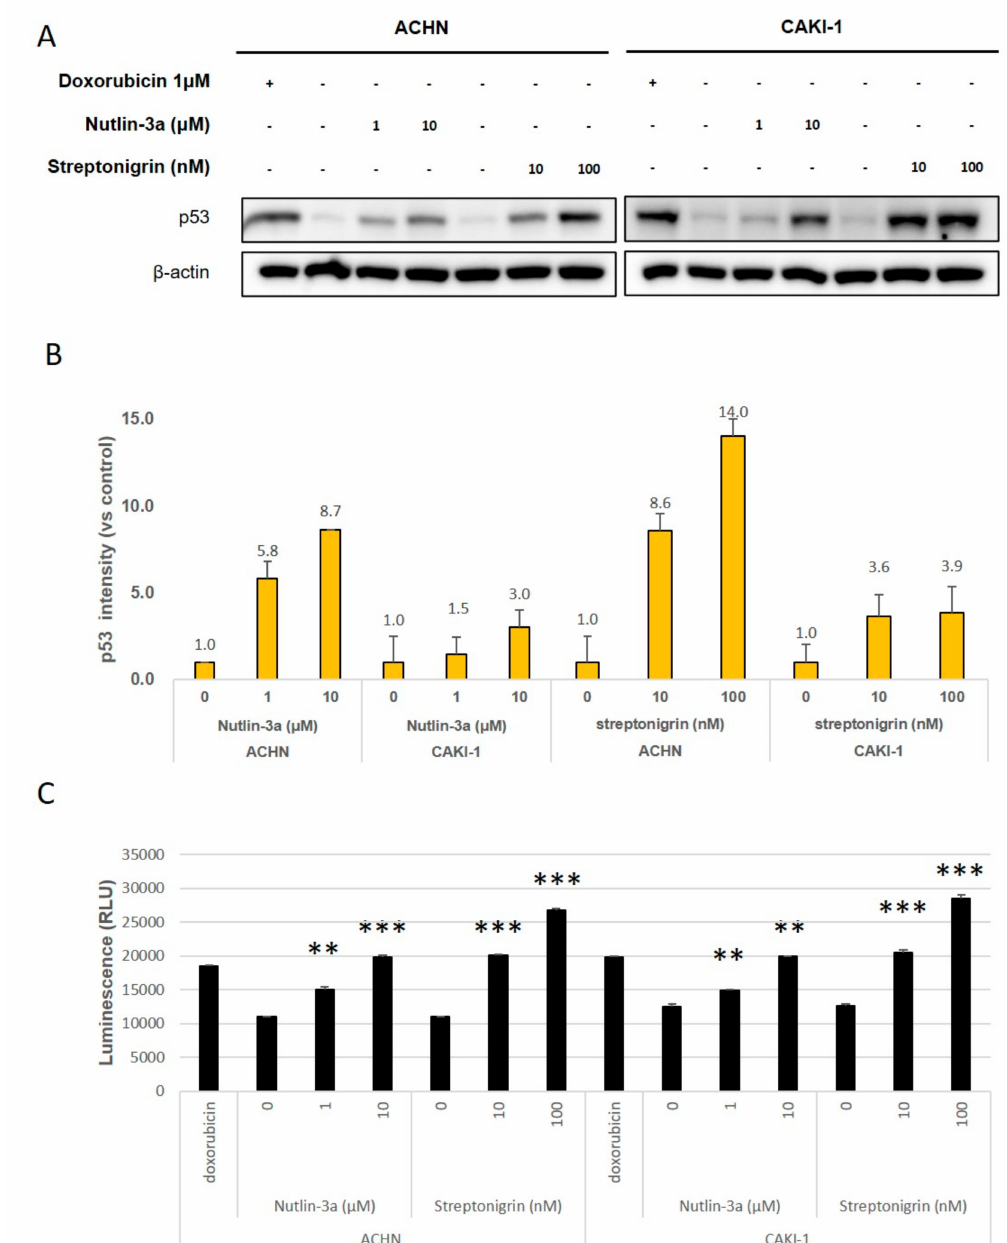
Figure 2. Streptonigrin and nutlin-3a increase p53 protein levels in a dose-dependent manner. ( A ) ACHN (left) and CAKI-1 (right) cells were treated with streptonigrin (which inhibits TGase 2-p53 binding) or nutlin-3a (which inhibits MDM2-p53 binding) for 24 h. Doxorubicin (1 µ M) was used as a positive control. ( B ) Image J analysis of the western blots in A. ( C ) The apoptosis assay was performed in the presence / absence of streptonigrin or nutlin-3a and was monitored by RealTime-Glo ™ annexin V under the conditions outlined in A. Cumulative data from three independent experiments are shown (mean ± SD; n = 3). ** p < 0.01 and *** p <